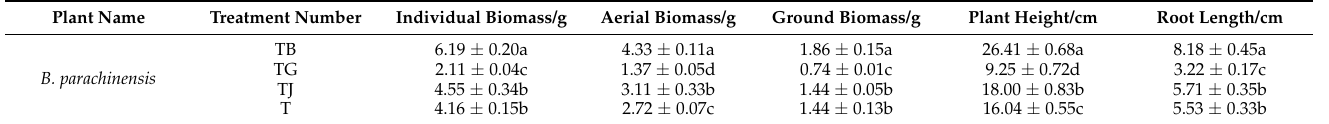
Table 3. Basic physical and chemical properties of tested soil.